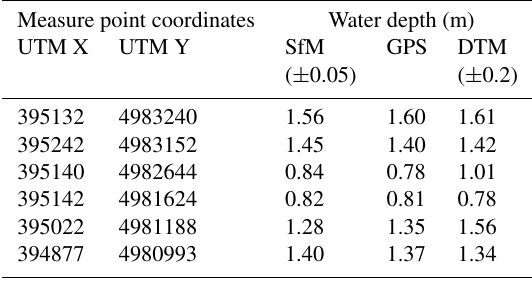
Table 7. Water height measurements obtained from structure-from- motion, GPS survey and simulation with DTM. Measure point